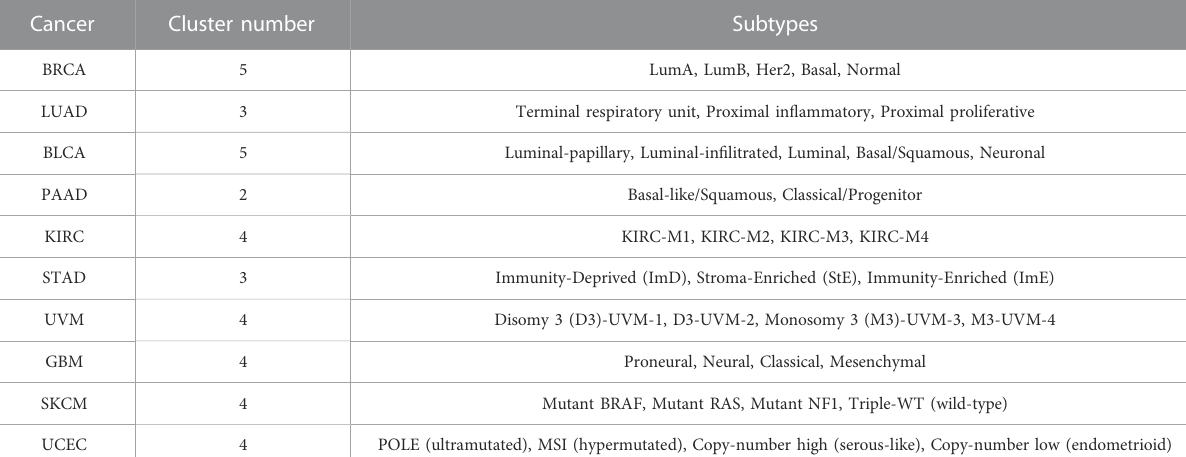
TABLE 4 The cluster number and subtypes of ten cancers. Cancer Cluster number